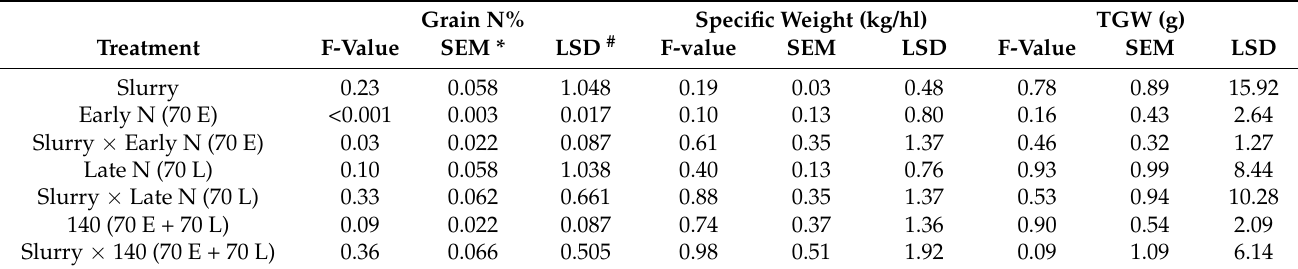
Table 9. Analysis of variance of 2017/18 grain quality parameters.